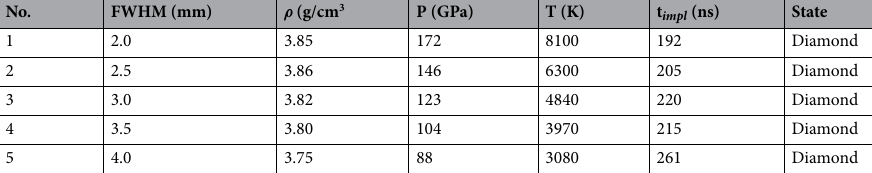
Table 3. Achieved physical conditions in compressed carbon using bunch intensity = 3 × 10 11 uranium ions, bunch length = 200 ns, particle energy = 2 GeV/u, initial sample radius, R si = 300 μm, sample mass = 6.4 mg/ cm.